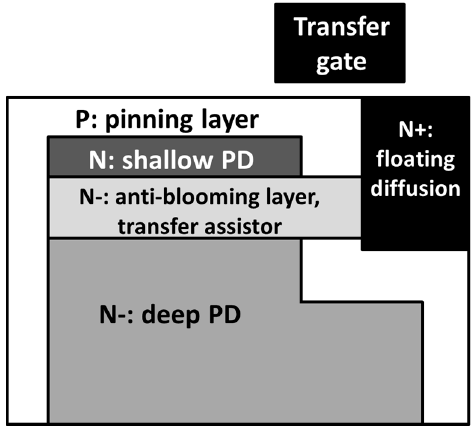
Figure 8. Schematic drawing of pixel design concept.